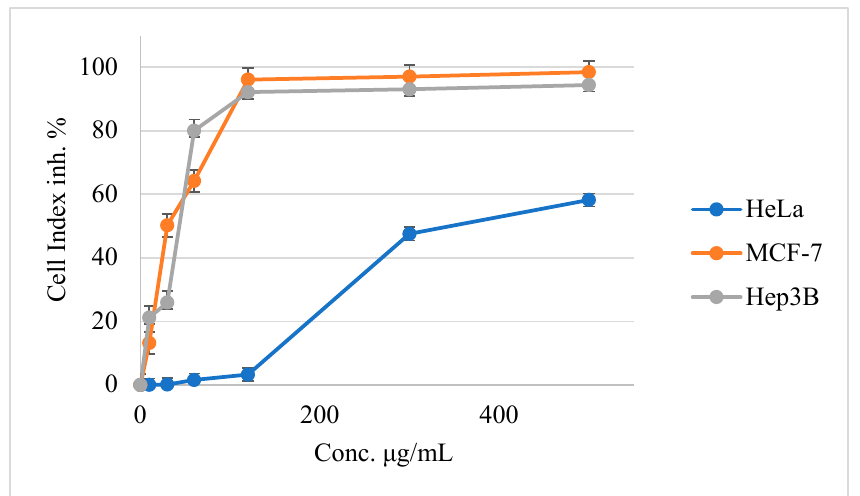
Figure 2. Cytotoxicity of PGEO was determined using an MTS assay against HeLa, MCF7, and Hep3B cancer cells. Table 3. Antimicrobial effects (MICs) of PGEO, Ciprofloxacin, Ampicillin, and Fluconazole ( µ g/mL). Microbial